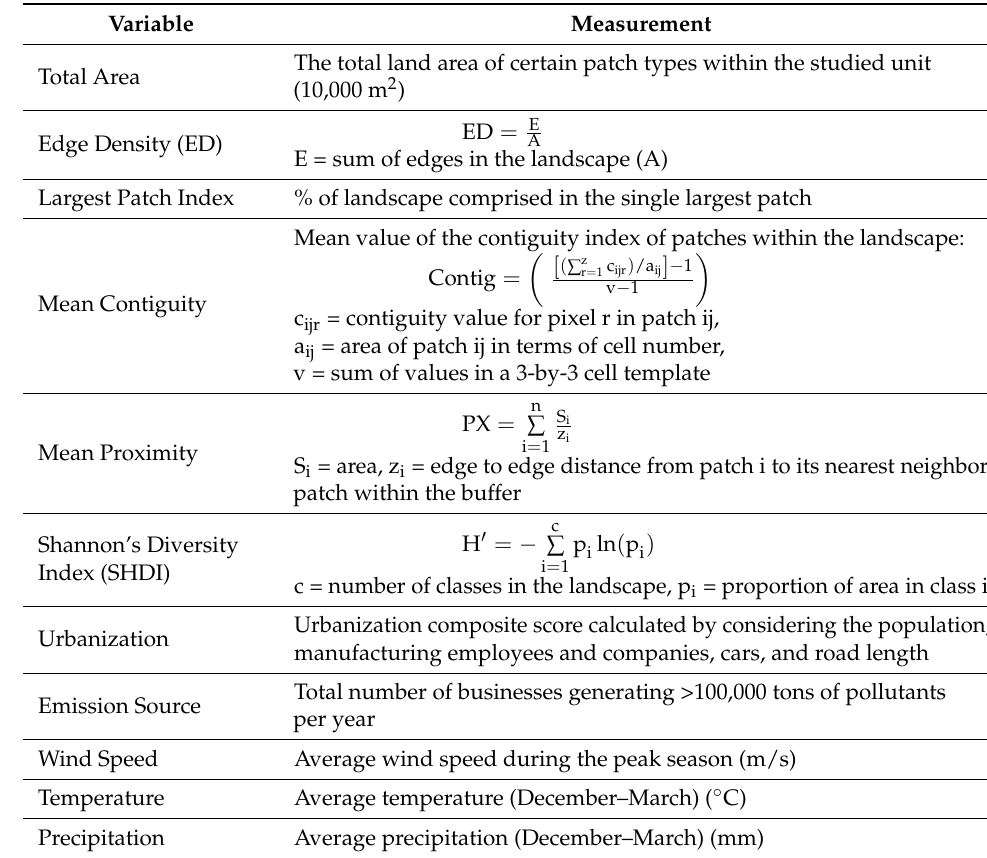
Figure 1. PM 10 and PM 2.5 distributions during the 2019 peak season. Table 1. Variables and